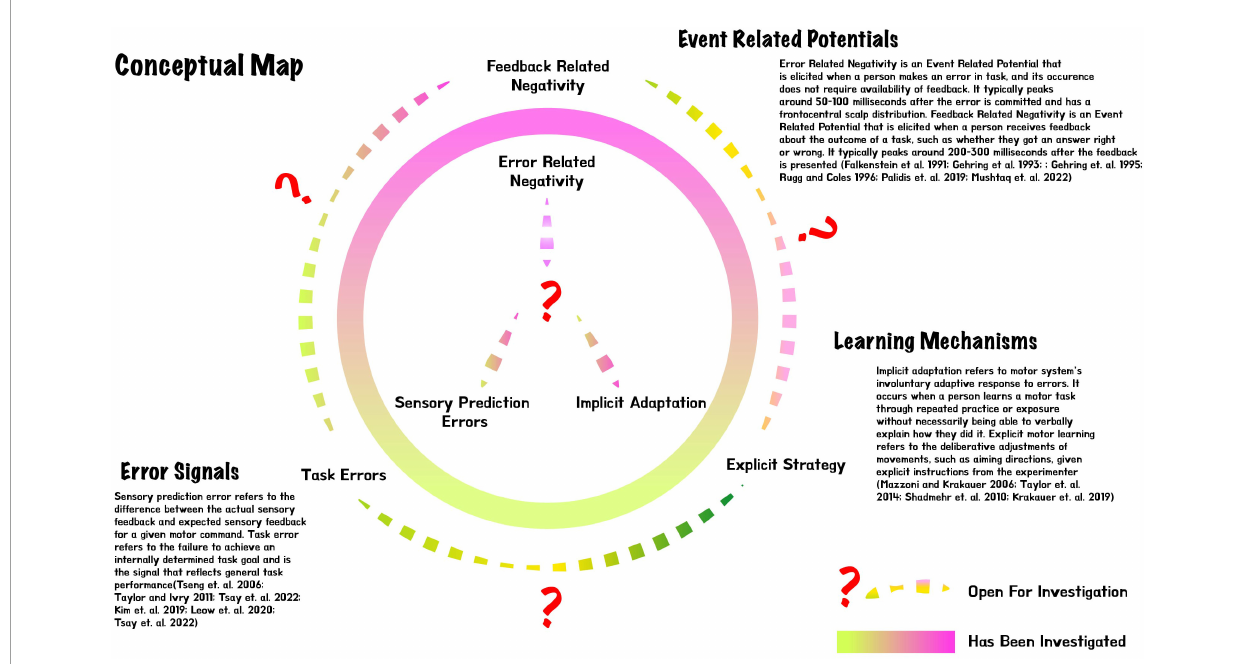
FIGURE1 Conceptual map for error-related negativity vs. feedback-related negativity, sensory prediction error vs. task error, and implicit vs. explicit motor